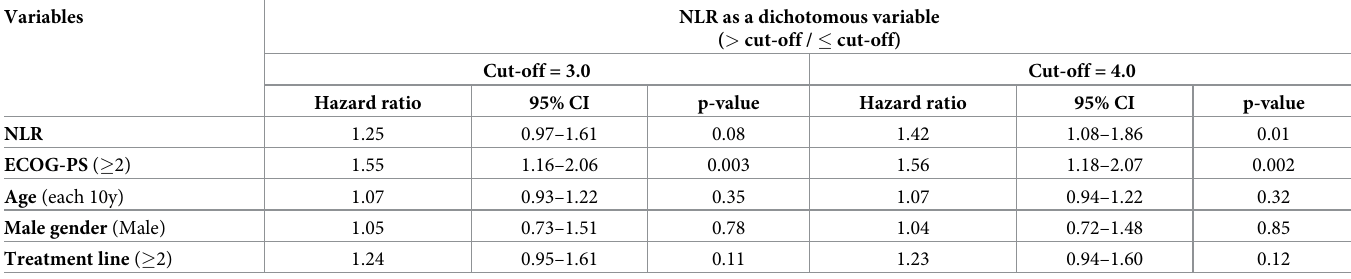
Table 3. Multivariate analysis in the overall cohort of patients receiving chemotherapy (cohort 1 + cohort 2, n = 451) with neutrophil-to-lymphocyte ratio as dichot- omous